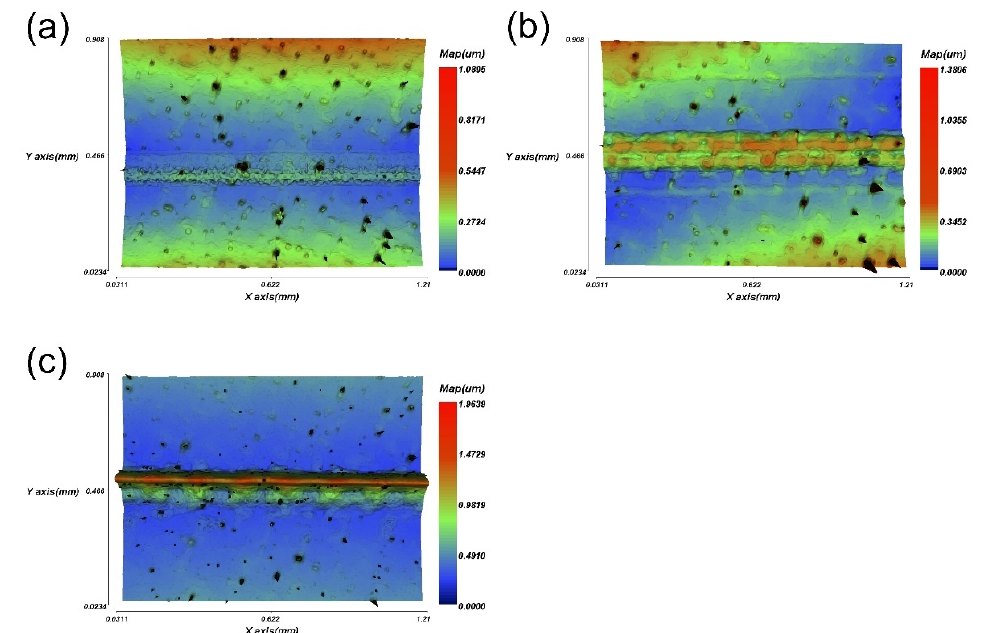
Figure 5. Interferometer images of printed strain gauges with stacked layers: ( a ) single layer, ( b ) three layers and ( c ) five layers. Table 2. Measured widths, thicknesses and corresponding gauge factors of printed strain-gauge patterns.